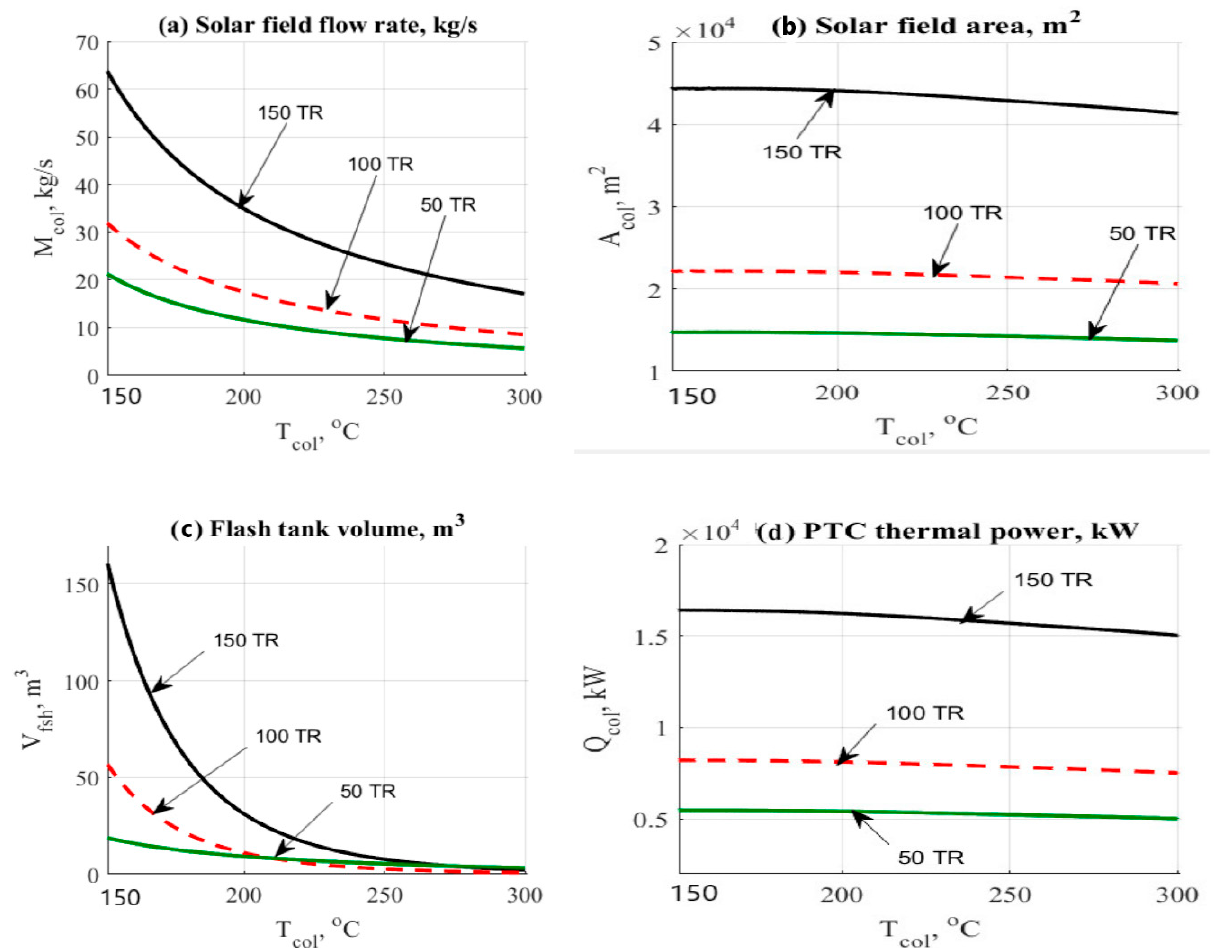
Figure 7. Data results for PTC/NH3 ‐ H2O cycle vs. variation in upper temperature of the solar field . ( a )Collector flow rate. ( b )Solar collector area. ( c )Flash tank volume. ( d )Solar thermal power.